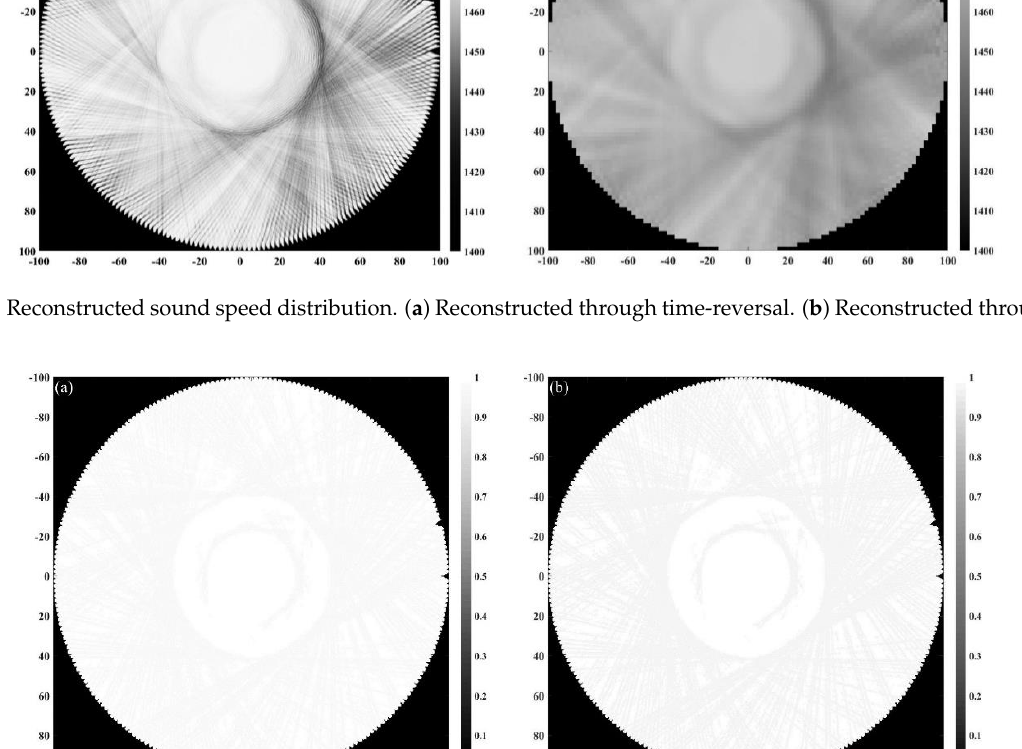
Figure 12. Reconstructed attenuation coefficient distribution. ( a ) Reconstructed through time-reversal. ( b ) Reconstructed through FBP.